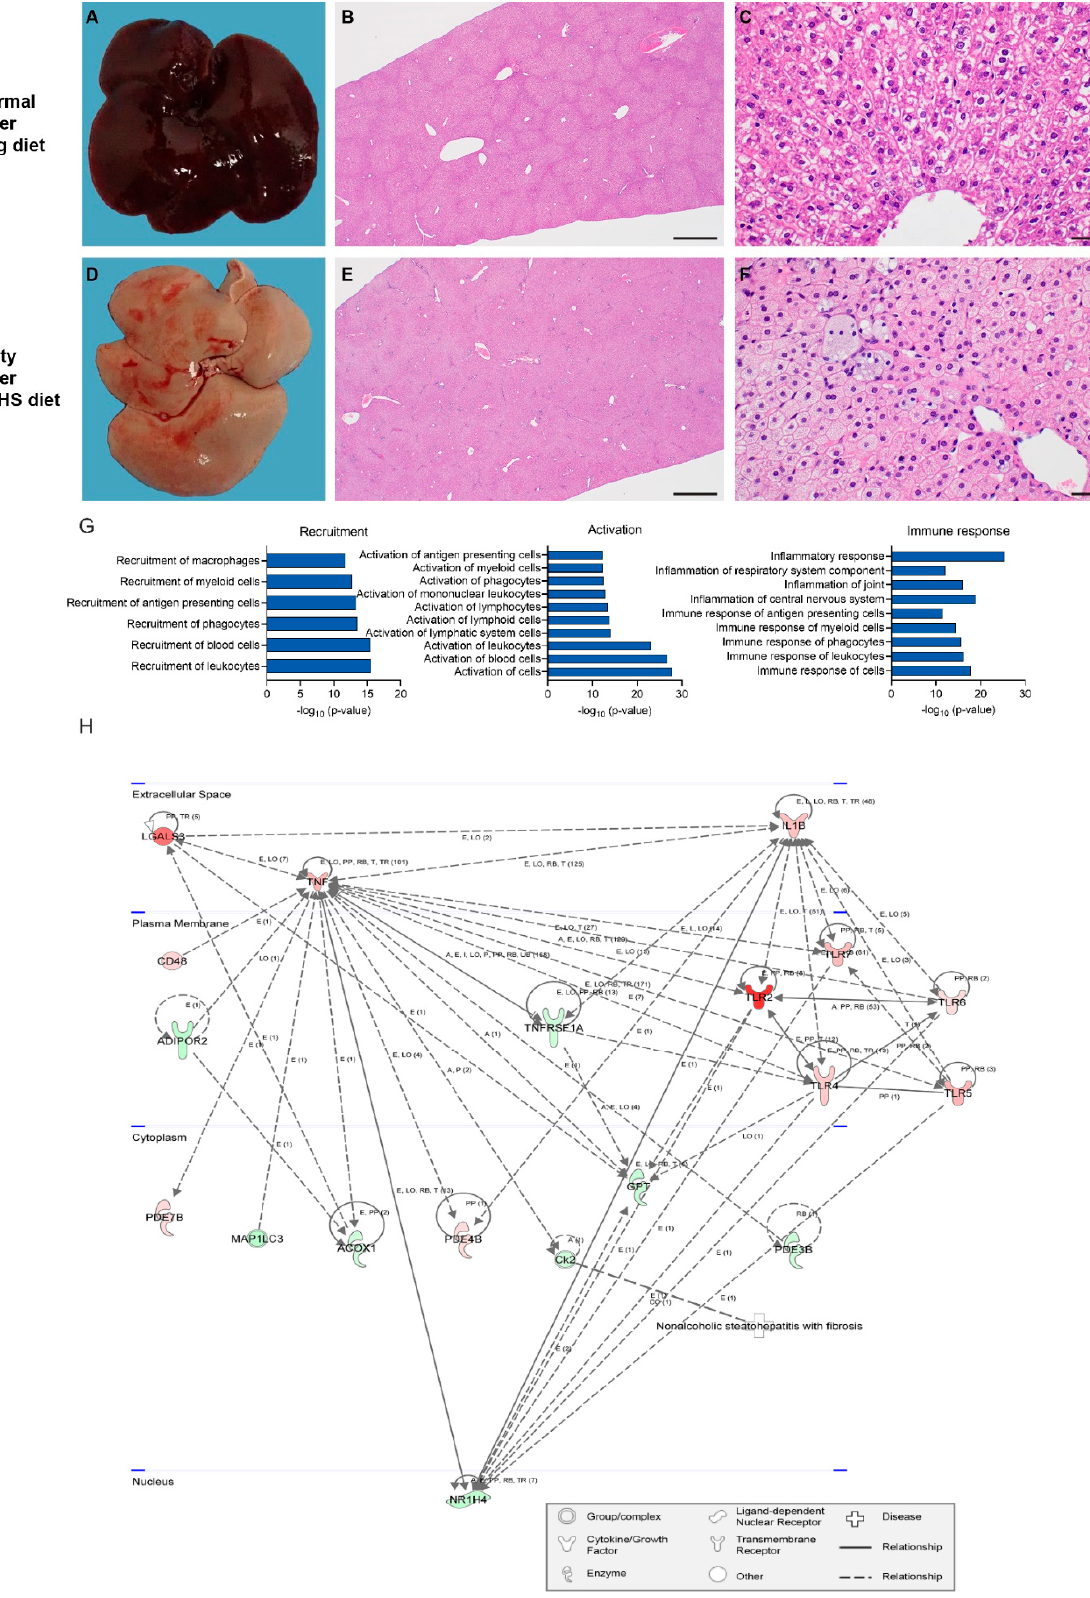
Figure 2. High-fat and high-sugar diet induces liver damage and systemic hyperlipidemia. Male Syrian hamsters were fed either a regular or high-fat high-sugar diet ad libitum and five animals from each group were sacrificed week 16 for anal- yses of liver tissue. ( A , D ) Gross imaging of a representative liver from one hamster on the RD and one hamster on the HFHS diet regimen. ( B , E ) 20× photomicrograph of H&E-stained slide. ( C , F ) 400× photomicrograph of H&E-stained slide. ( G ) RNA was isolated for gene expression analyses from liver tissue at 16 weeks. Using Integrated Pathway Analysis (Qiagen), significantly upregulated canonical pathways were identified. Graphs show pathways associated with cell re- cruitment, activation, and immunological inflammation ( p > 0.05, z -score ≤ − 2 or ≥ 2). ( H ) Integrated Pathway Analysis (Qiagen) was used to depict the gene network associated with nonalcoholic steatohepatitis. Symbols refer to legend below figure. Red: gene upregulation in high-fat high-sugar animals as compared to regular diet animals. Green: downregulation in comparison to regular diet. To further characterize the effect of the HFHS diet regimen on the liver, we evaluated global changes in the gene expression after 16 weeks. Principal components analysis of the complete gene expression profile revealed expected grouping with each diet regimen group containing their associated replicates (Supplementary Materials Figure S1A, n = 5 (RD), 4 HFHS). In total, 2114 genes were significantly, differentially expressed ( p < 0.05 and >2 fold) in the liver. To assess the enrichment of these differential genes, they were imported into Ingenuity Pathway Analysis (IPA) software. The results show that in the comparison of HFHS to RD animals 124 canonical pathways were significantly enriched